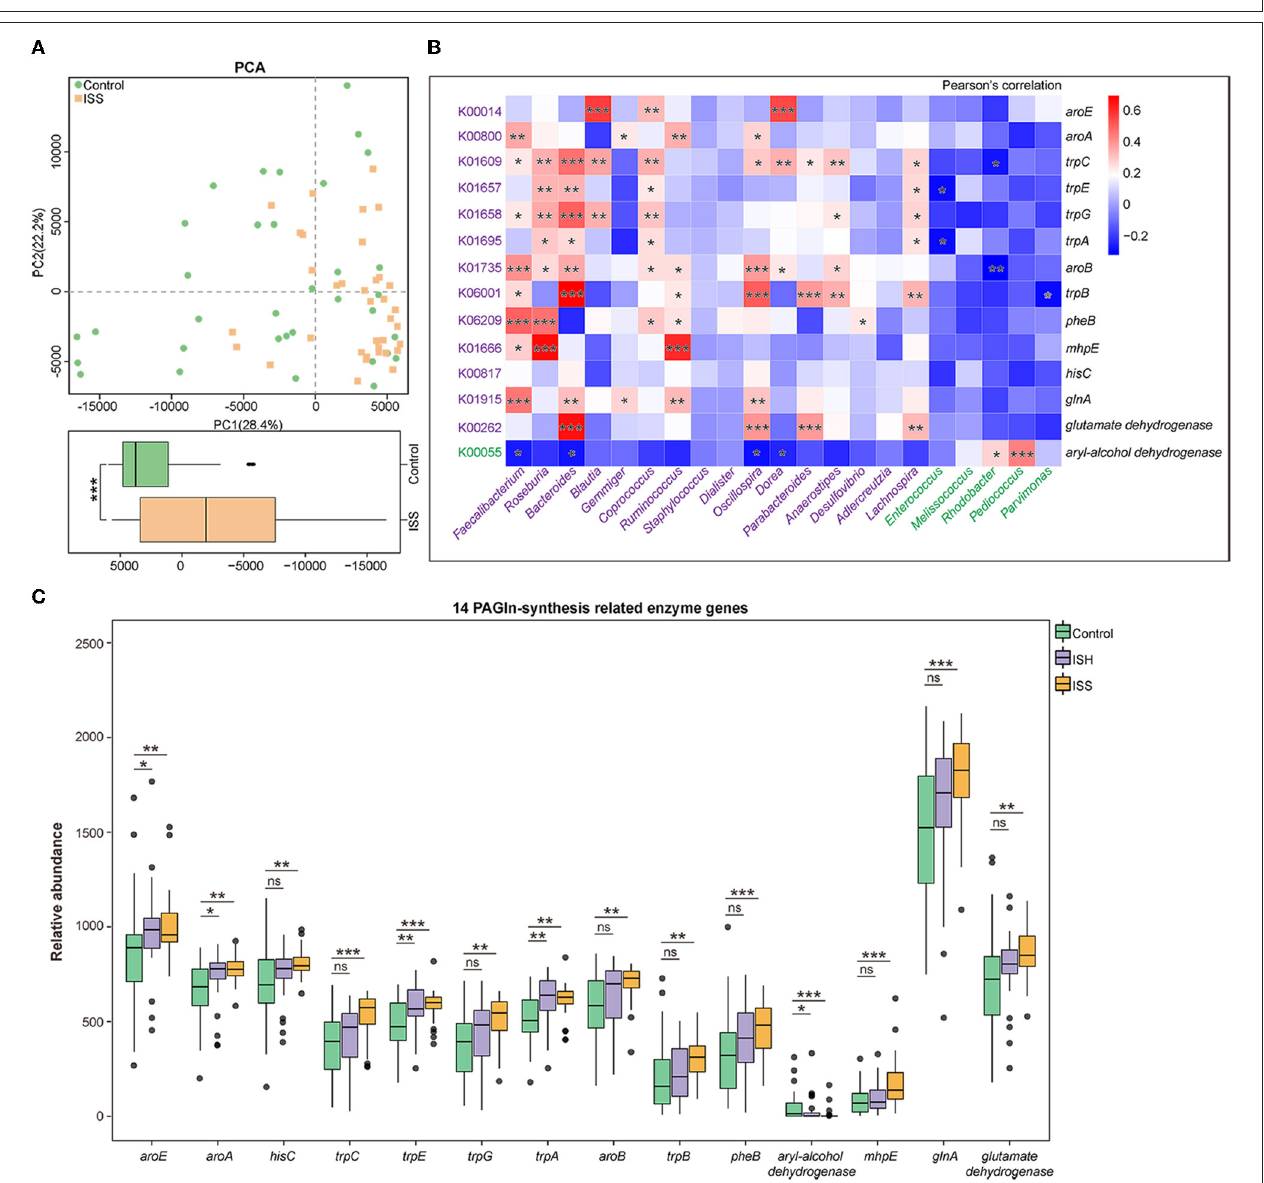
FIGURE 2 | (C) The ROC curve for the ISS risk score to verify the predicted capability of the model (AUC = 0.963, P < 0.001, 95% CI: 0.889–0.993). (D) Right panel; cladogram reveals different taxonomic compositions between the control (green) and ISS (orange) groups. Left panel; LDA coupled with effect size shows differentially enriched microbiota at all taxonomic levels in the control and ISS groups at the threshold of absolute LDA score (log 10) > 2.0. (E) The bar chart shows the relative abundance of the genera enriched in the ISS group. *, P < 0.05; **, P < 0.01; ***, P < 0.001; Wilcoxon rank-sum test. n = 35 for the control group, n = 32 for the ISH group, n = 36 for the ISS group.